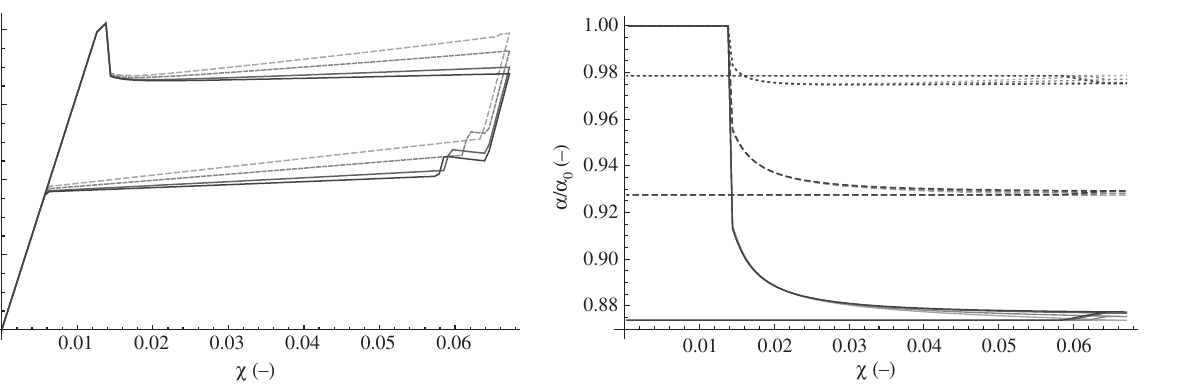
over strain for varying heat conductivity Figure 3 Stress σ 11 κ ∈ {0.010, 0.015, 0.030, 0.050} GPa/K.